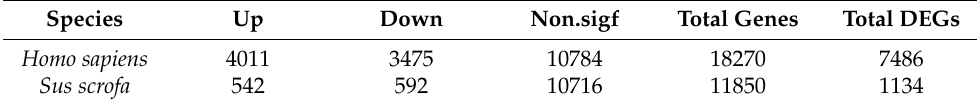
Table 2. DEGs in H. sapiens (HIEC cells) and S. scrofa (IPEC cells) at 24 hpi vs no infected cells.